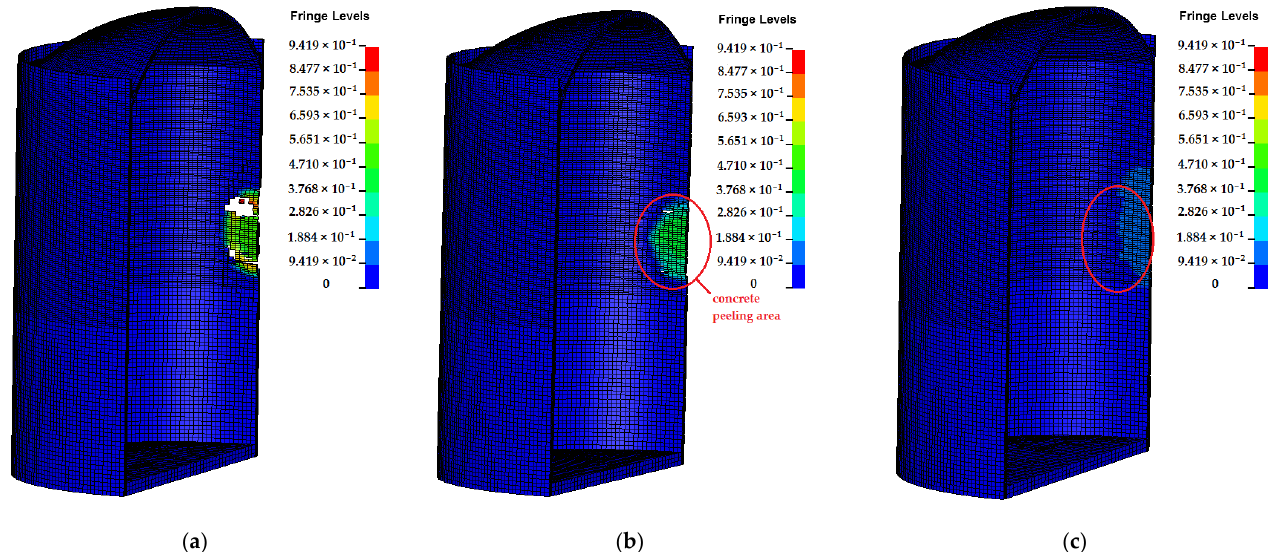
Figure 16. Contours of the maximum impact displacement and concrete peeling off area of full SC containment. ( a ) t = 18 mm ; ( b ) t = 20 mm; ( c ) t = 22 mm.